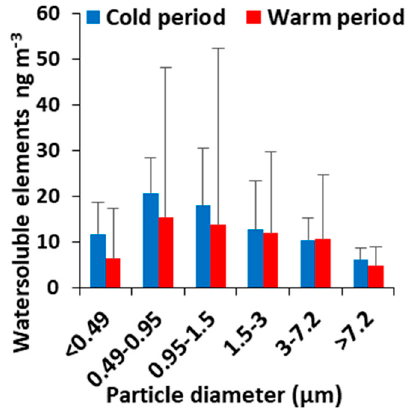
Figure 2. Average concentrations of water-soluble elements (cold and warm periods).